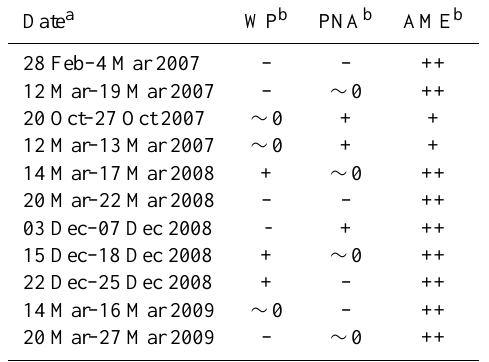
a The dates correspond to the times when Arctic haze events are observed by CALIOP. b A double sign indicates absolute values of the index greater than two standard de- viations during the 3-day initial phase of export. Near zero values are those whose absolute values within ± 0.5 standard deviations.